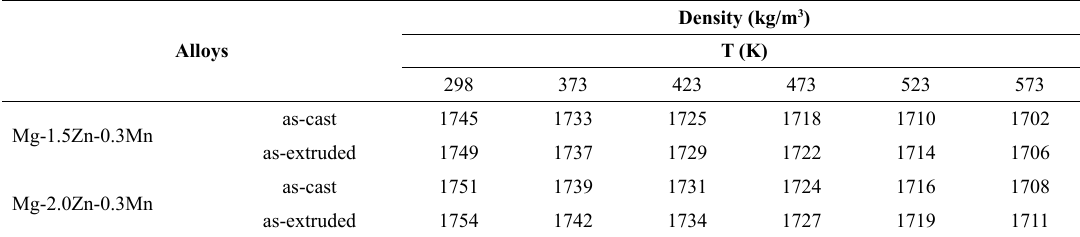
Table 2. Densities of the Mg-xZn-0.3Mn alloys